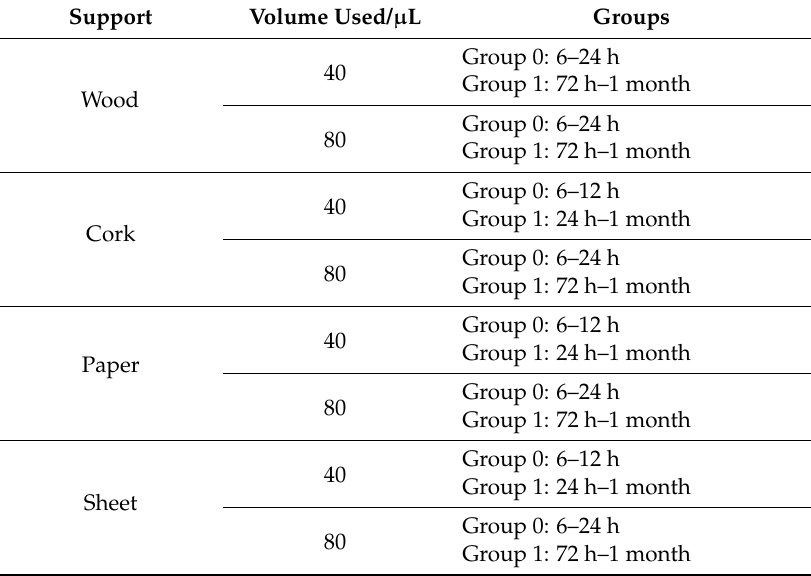
Table 1. Groups of samples providing a 100% correct classification in the LDA for different sample volumes and different supporting